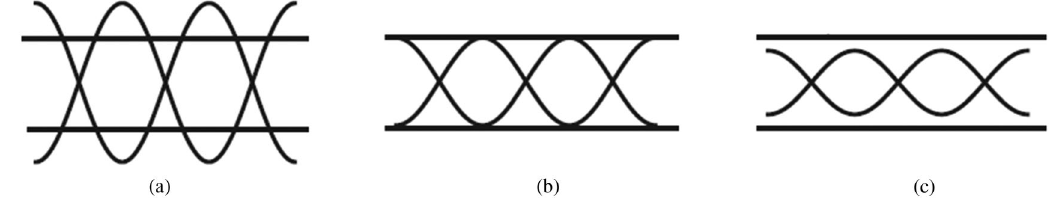
FIG. 1. Typical illustrations of sound standing waves in air columns in a pipe in introductory physics